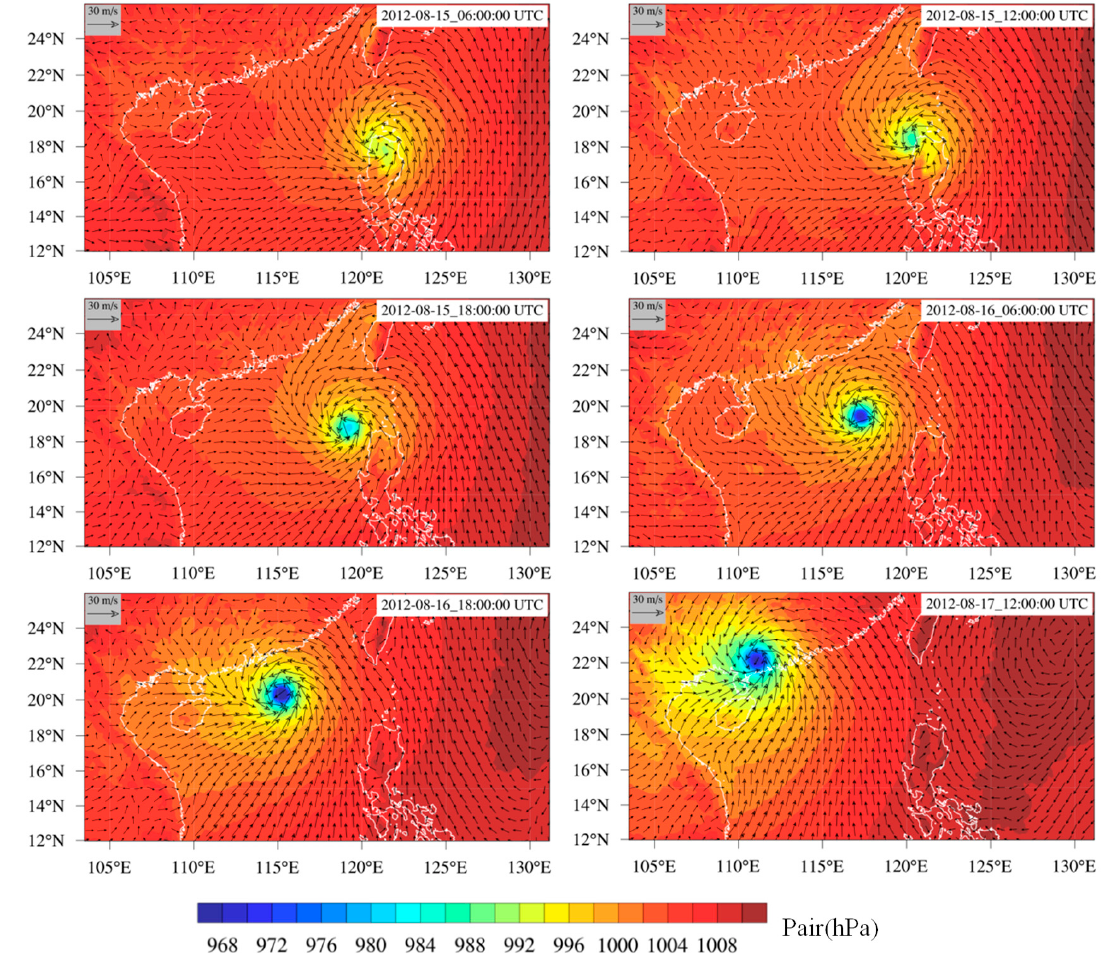
Figure 6. Spatial distribution of the pressure field influenced by typhoon Kai-tak.